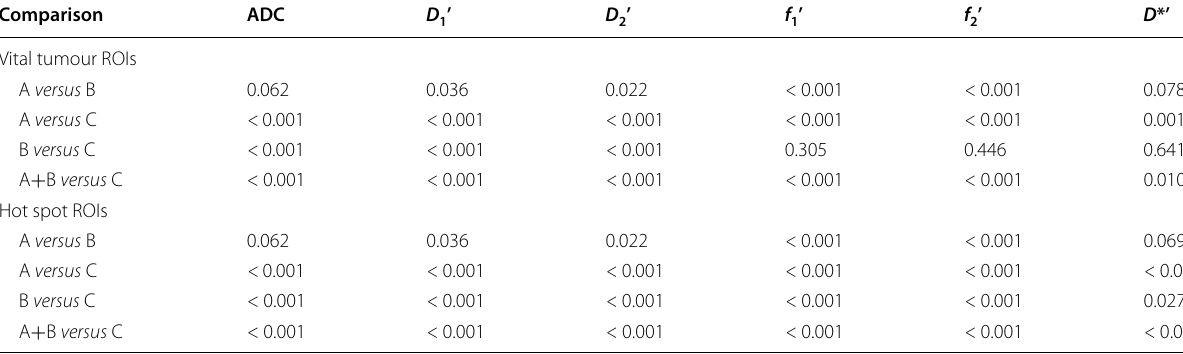
See Table 3 for abbreviations